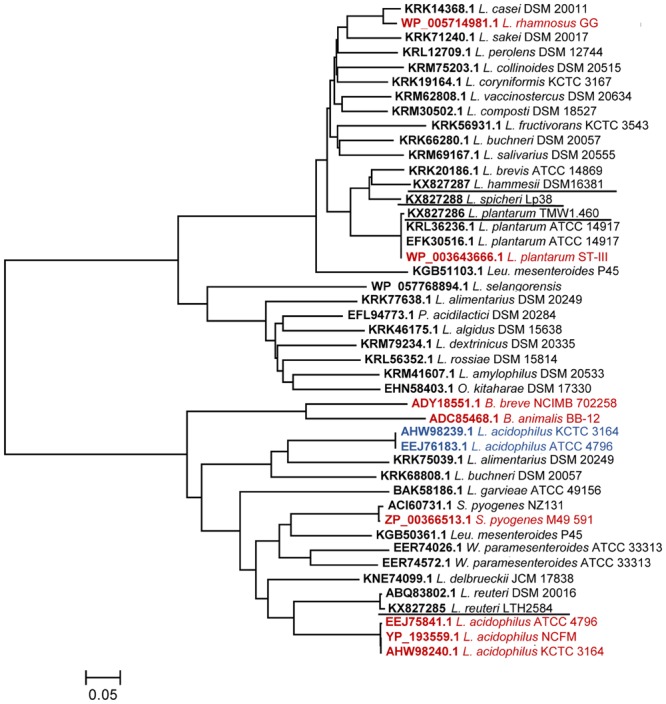
Phylogenetic tree of linoleate hydratases (LAHs). The evolutionary relationships are shown with scale bar line which represents an evolutionary distance of 0.05. Linoleate 10-hydratases reported in the literature are highlighted in red, linoleate 13-hydratases are highlighted in blue, linoleate 10-hydratases that were characterized in this study are underlined.